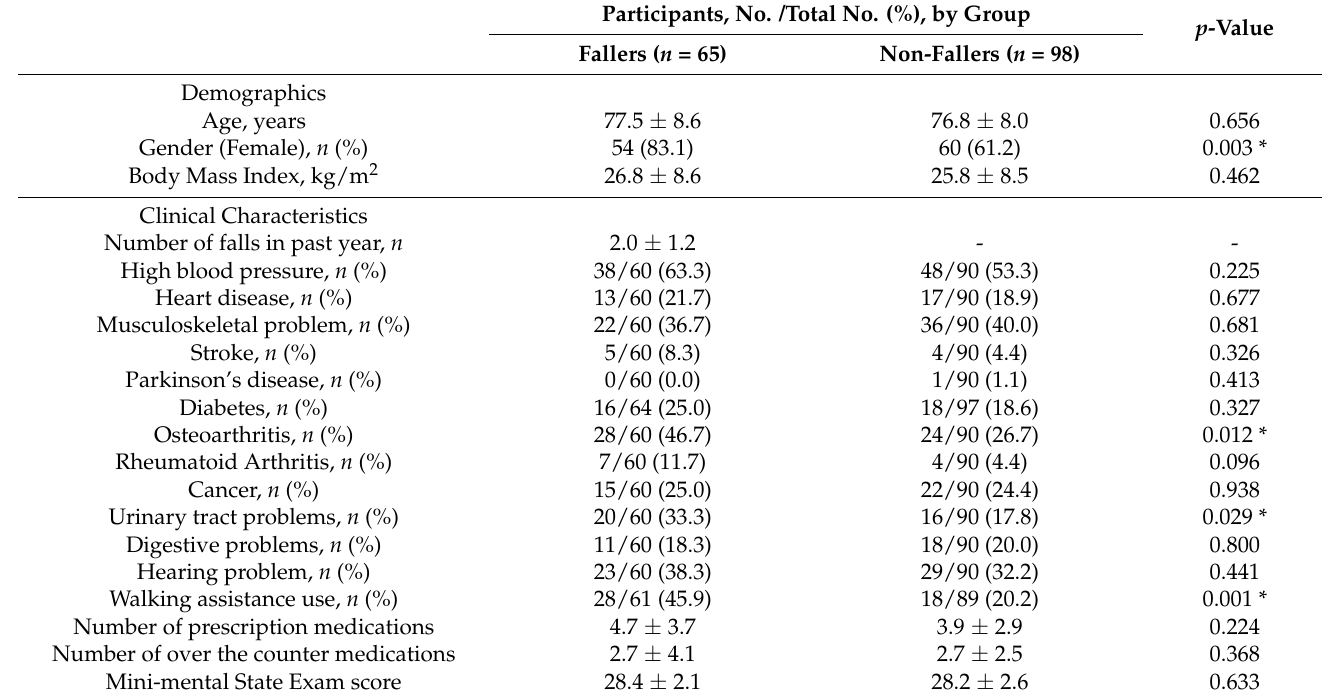
Table 2. Demographic and clinical characteristics at baseline for the fallers and non-fallers